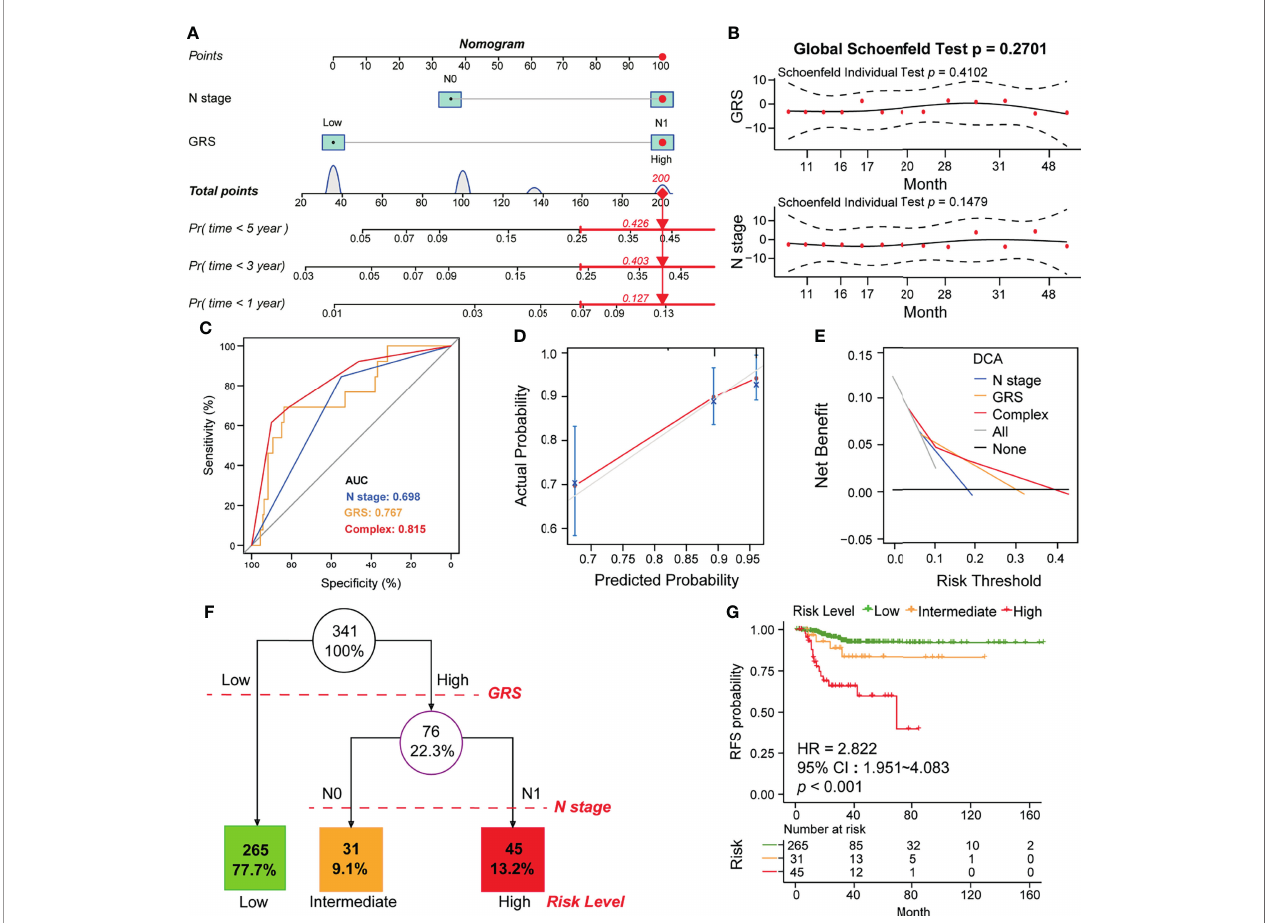
FIGURE 8 | Construction of the GRS-based nomogram and clinical decision tree. (A) Construction of the nomogram based on GRS and N stage. An example of the use of the nomogram is shown in red. The risk of 1-year, 3-year, and 5-year recurrence is indicated by a red arrow. For example, patients with N0 and high GRS were used. (B) Residual analysis to test whether the nomogram holds. (C) Calibration analysis to test the predictive accuracy of the nomogram. (D) ROC analysis comparing the predictive sensitivity of the nomogram and N-stage alone to GRS. (E) DCA analysis comparing the net survival bene fi t of the nomogram, GRS and N- stage. (F) Construction of a clinical decision tree based on GRS and N stage. (G) K-M analysis to compare survival differences between different risk